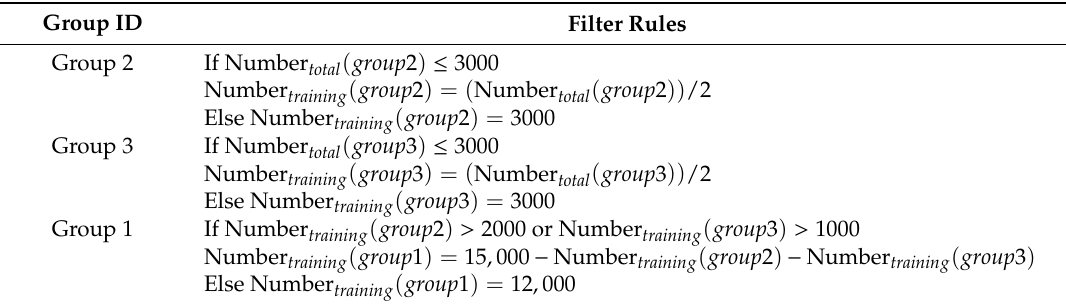
Table 2. Training sample filter